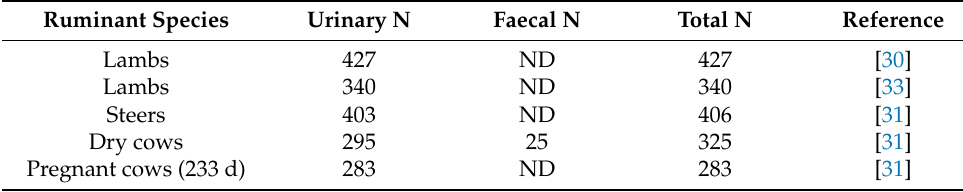
Table 2. Maintenance N requirement (mg/kg W .75 ) determined by IIT.